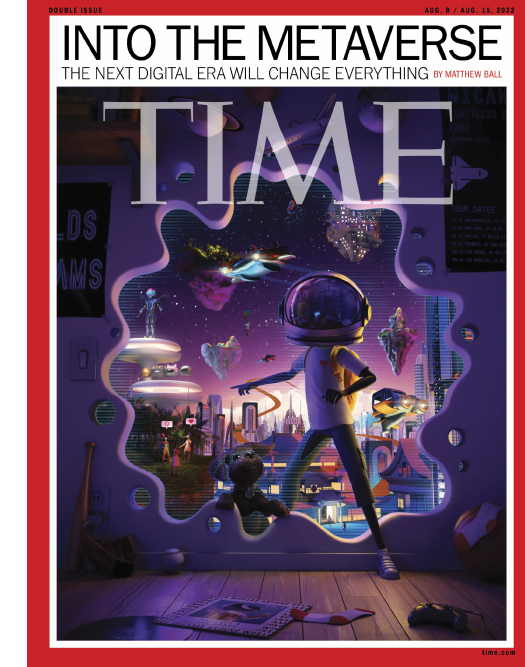
Fig. 1 Metaverse cover in Time Journal [1]